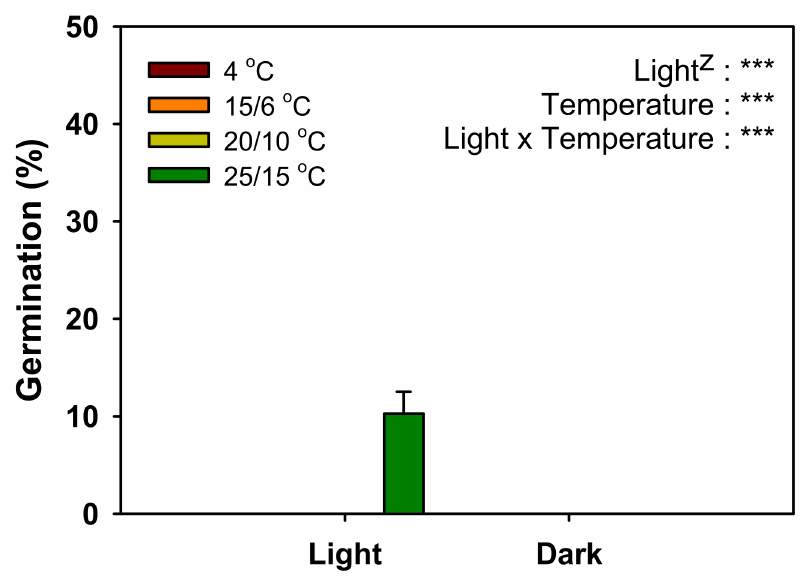
Figure 4. Germination of V. sibiricum seeds as affected by light conditions in response to four temper- ature regimes. Germination (%) was calculated at four weeks after incubation. Error bars indicate mean ± SE of four replicates. Results of a two-way analysis of variance applied to germination percentages of V. sibiricum seeds affected by light and temperatures ( *** significant at p < 0.0001).